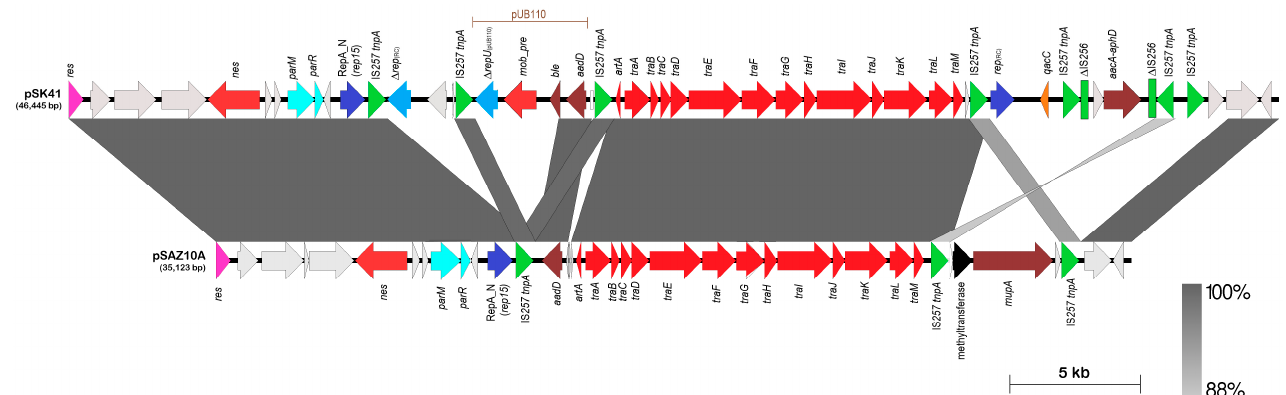
Figure 6. Comparative linear genetic maps of plasmid pSAZ10A with the conjugative plasmid pSK41 (accession no. AF051917; [80]). Arrows indicate the extent and direction of genes and ORFs while regions with >88% nucleotide sequence identities are depicted as shaded grey areas with darker shades of grey indicating higher nucleotide sequence identities. The RepA_N replicase (which was typed as rep15 by PlasmidFinder) is shown as a dark blue arrow, while lighter blue arrows depict partial or truncated replicase genes, which are labeled with a “ ∆ ” prefix. The parM-parR genes that encode the pSK41 plasmid partitioning system are indicated as sky-blue arrows upstream of the repA_N replicase gene, while the res gene that encodes a serine recombinase, which resolves plasmid multimers into monomers is shown as a pink arrow at the start of the map. The tra genes responsible for conjugative transfer are shown as red arrows, as is the relaxase gene, nes , that acts on the origin of transfer. Antibiotic resistance genes are indicated in brown arrows while the qacC biocide resistance gene in pSK41 is shown in orange. IS element-encoded transposases are depicted as green arrows with the two partial IS 256 elements in pSK41 depicted in green boxes and labeled as ∆ IS 256 . In pSK41, IS 257 delimits segments that correspond to cointegrated copies of smaller plasmids, and this includes pUB110, which encodes the aadD aminoglycoside and ble bleomycin resistance genes (labeled as pUB110) as well as qacC on another rolling circle replication plasmid with the replicase labeled as rep (RC) [19]. ORFs encoding hypothetical proteins are shown as light grey